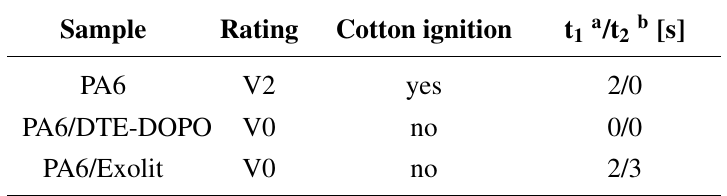
Table 4. Results of UL94 flammability test for PA6